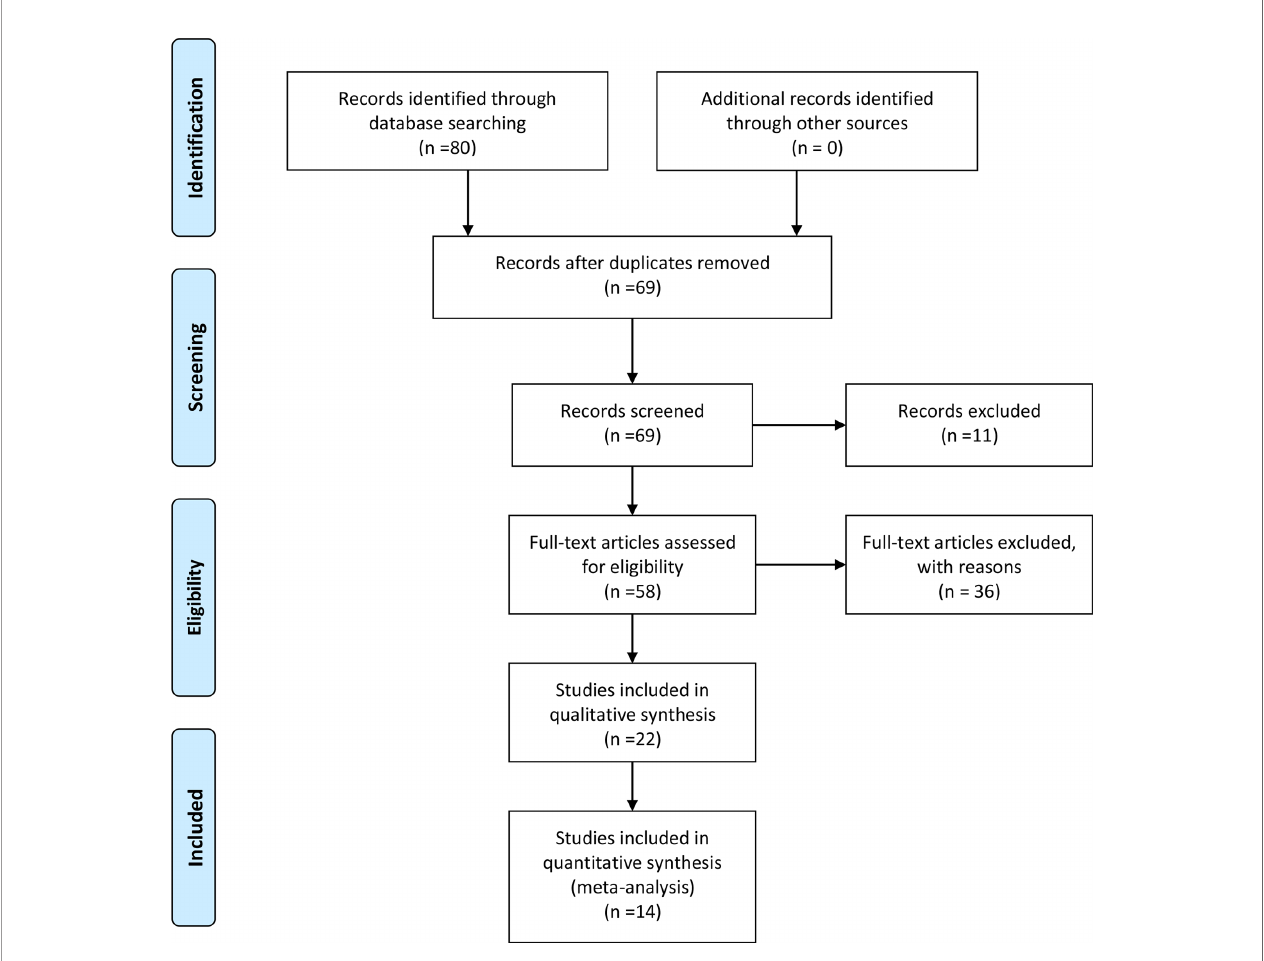
FIGURE 1 | Study selection fl